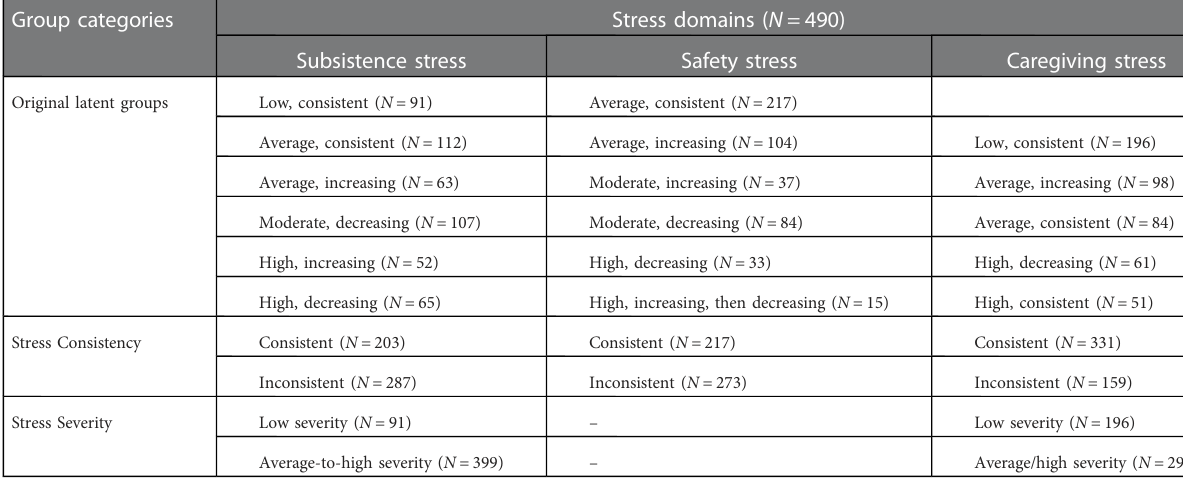
TABLE 2 Classi fi cation of stress trajectory groups and sample sizes for each domain.